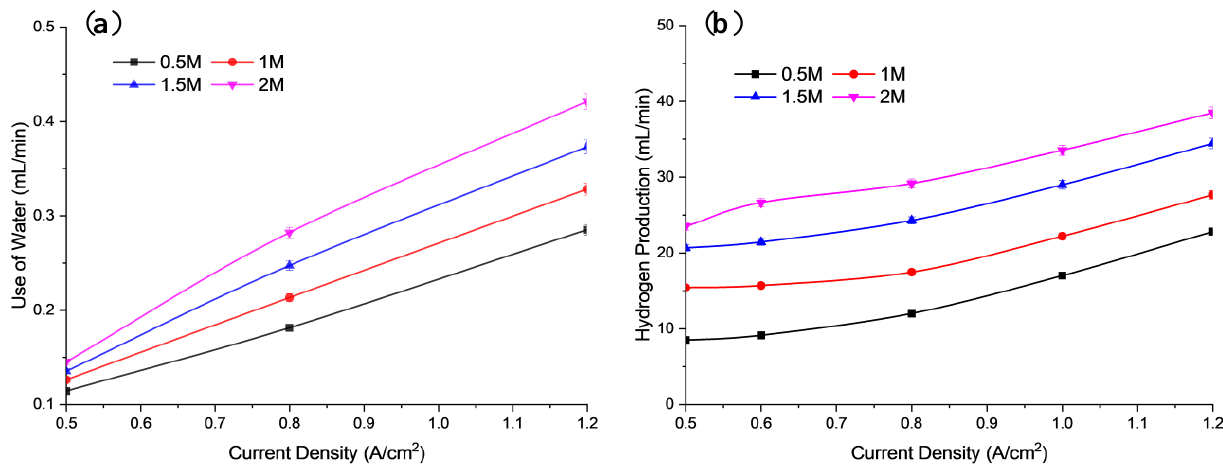
Figure 3. Profile of ( a ) use of water, ( b ) Hydrogen production for different alkaline concentrations at 6 mL/min flow rate and 30 ◦ C operating